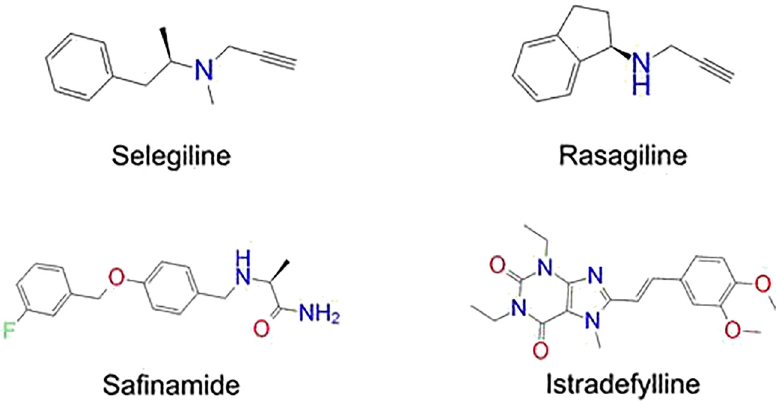
Figure 1: Chemical structures of monoamine oxidase B